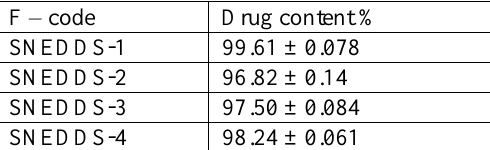
Table 6. The drug content percent of piroxicam liquid self nanoemulsion (mean ±SD) n=3.